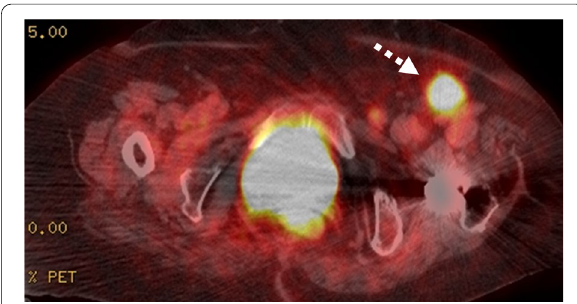
Fig. 3 FDG accumulation was found only in the left inguinal region by PET (dotted arrow)